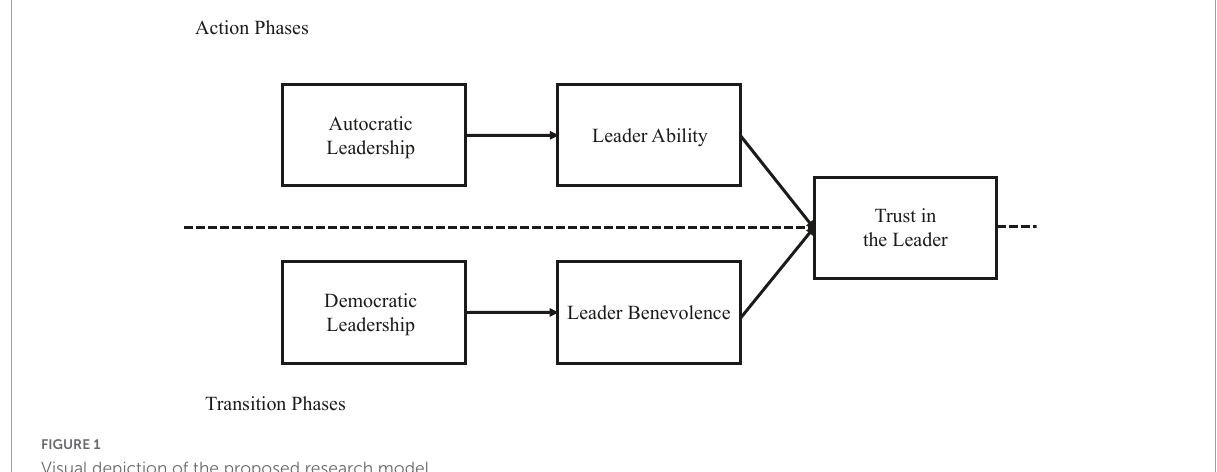
FIGURE1 Visual depiction of the proposed research